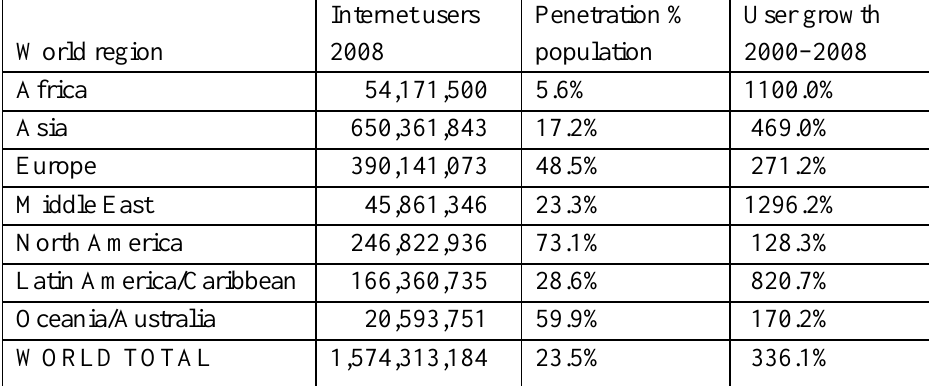
Internet Users, Penetration, and Growth Statistics (from Internet Usage Statistics, 2009) World region